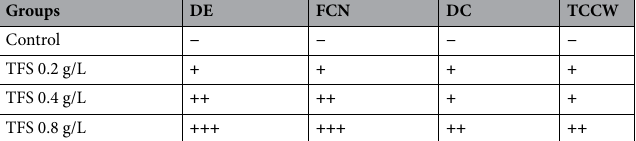
Table 4. Degree of meristematic cell damages induced by Trifoxystrobin. DE damaged epidermis, FCN flattened cell nucleus, DC damaged cortex, TCCW thickness in cortex cell wall, (−): undamaged, (+): slightly damaged, (++): moderately damaged, (+++): critically